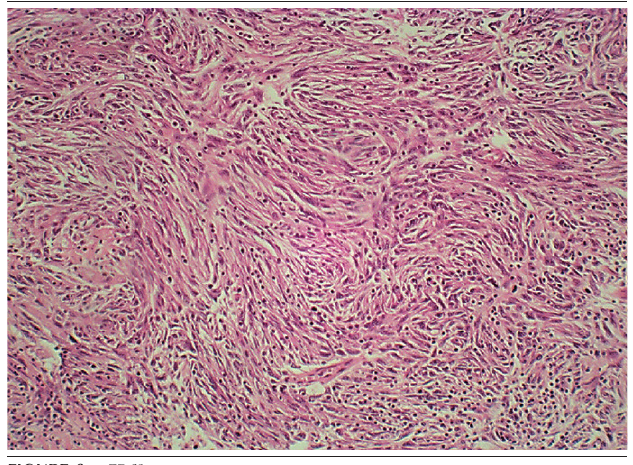
FIguRE 8 − FDCS Spindle tumor cells are admixed with numerous lymphocytes. FDCS: follicular dendritic cell